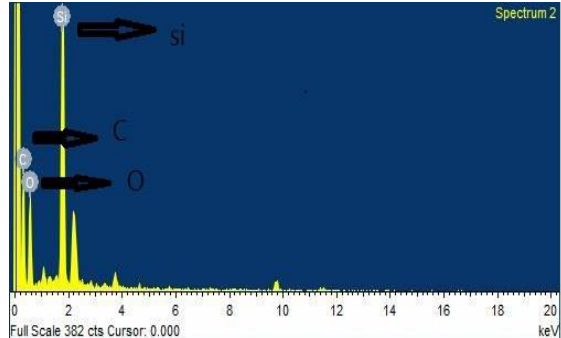
Figure 6: EDS spectra showing Si, C, O elements on the surface of reinforced sample by SiO nanofiller. 2 Transverse strength, impact strength, surface hardness, surface roughness, water sorption and solubility: